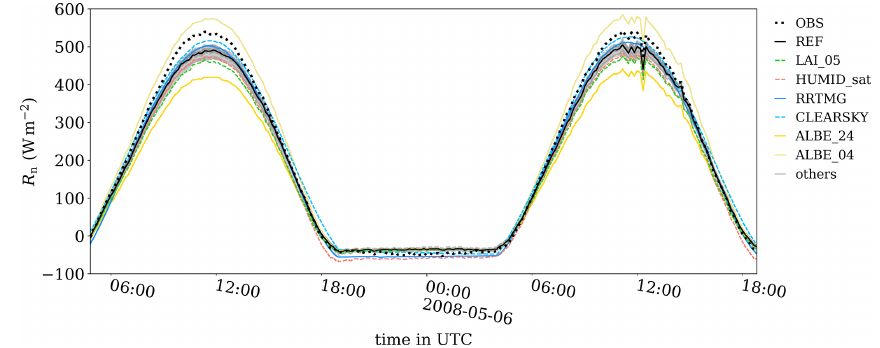
Figure 3. Time series of surface net radiation R n as measured at Cabauw (OBS) and domain-averaged R n for all simulated cases listed in Table 5. Only case REF and some relevant cases are highlighted; all others are shown in gray. The gray transparent area shows minimum and maximum values of the net radiation for case REF based on instantaneous hourly horizontal cross sections.